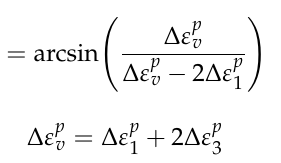
Figure 5. Regression curves of ( a ) elastic modulus vs. confining pressure and ( b ) Poisson’s ratios vs. confining pressure.